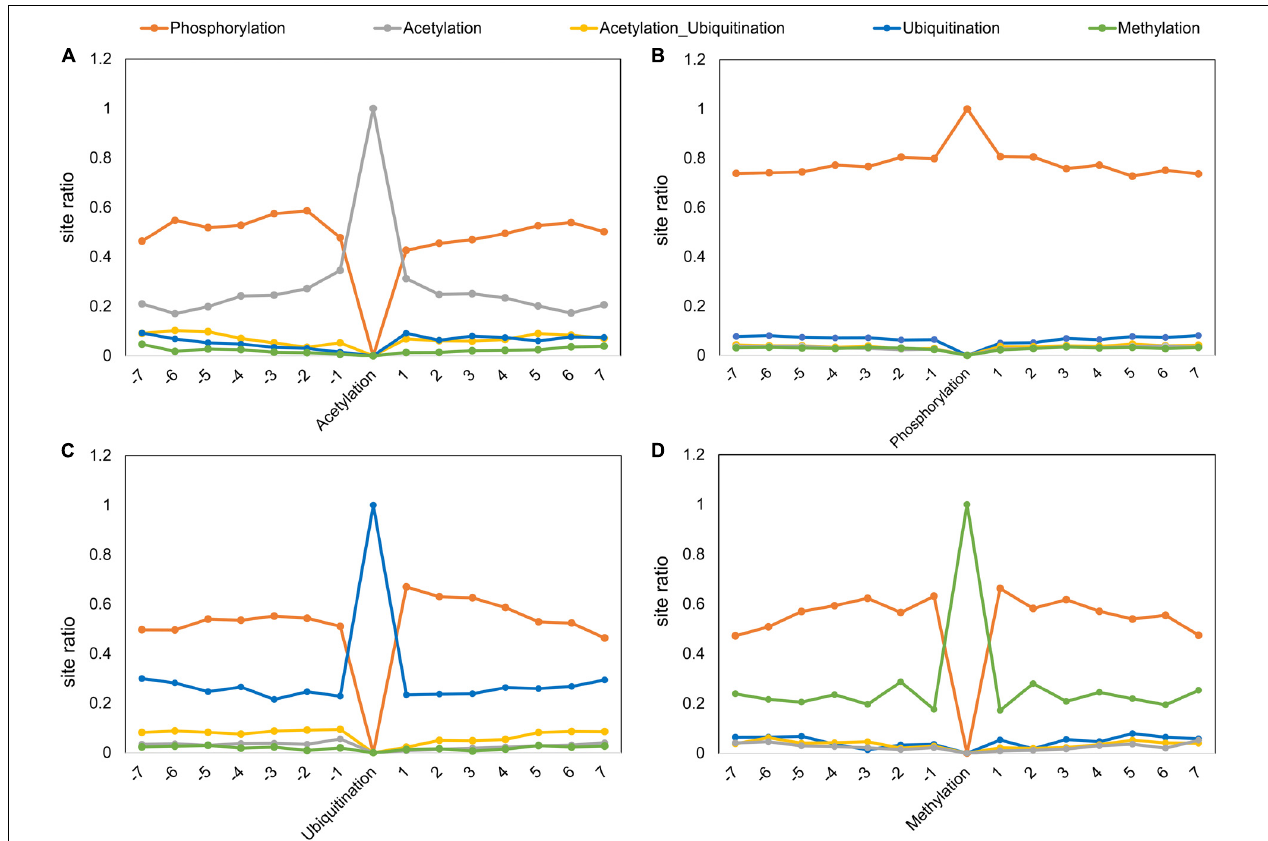
FIGURE 5 | Post-translational modification motifs and occurrence of other PTMs or combination around (A) Acetylation, (B) phosphorylation, (C) ubiquitination, and (D) methylation. The x -axis represents the site position in the motif. The y -axis represents the ratio of sites with respect to the total sites for a particular